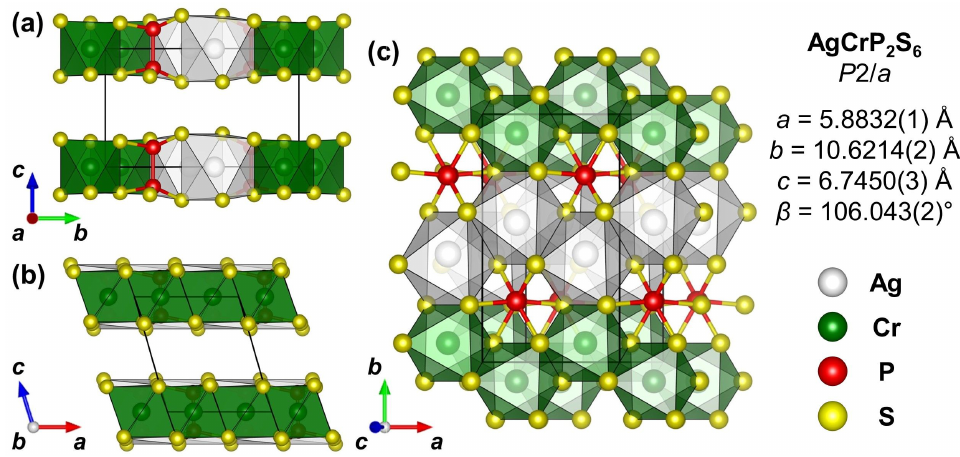
Figure 6. Refined crystal structure model of AgCrP 2 S 6 after Rietveld refinement. View along a in ( a ), along b in ( b ) and along c ∗ in ( c ). The CrS 6 and AgS 6 coordination environments are shown in the color of the respective central